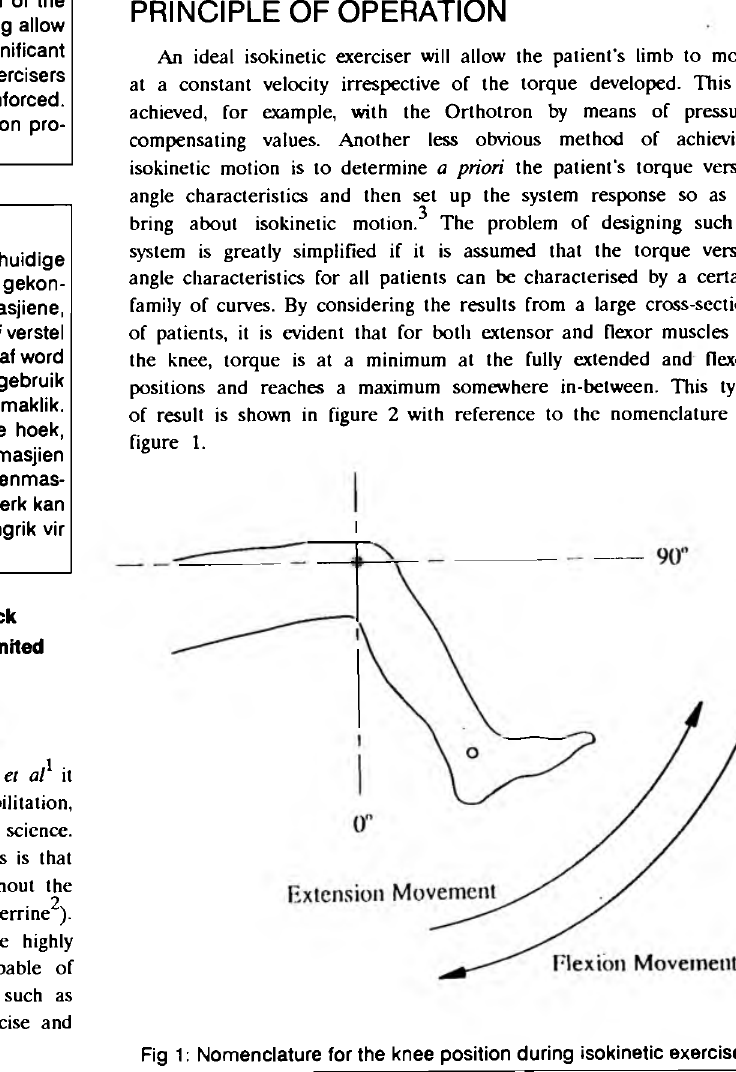
Fig 1: Nomenclature for the knee position during isokinetic